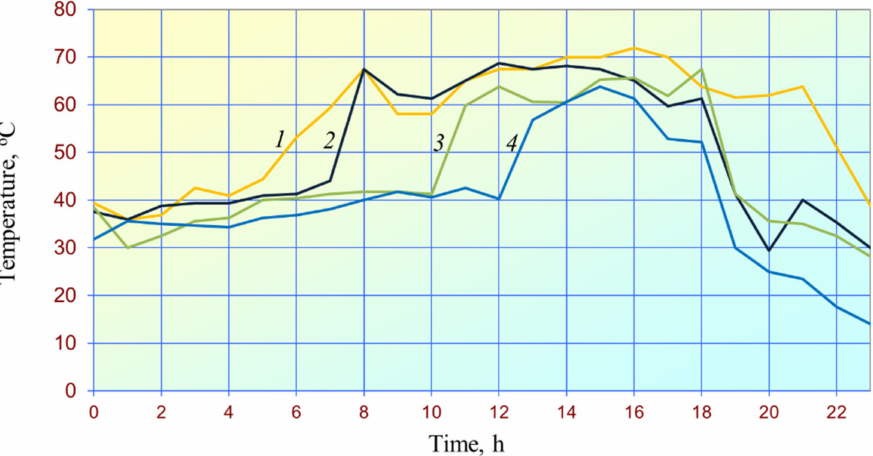
Figure 6. Variation in the average temperature of the heating agent in collector group 1 during the day in sunny weather at different outdoor temperatures: 1–27 June 2017 (+30 ◦ C); 2–8 April 2018 (+3 ◦ C); 3–11 March 2018 ( − 16 ◦ C); 4–25 February 2018 ( − 24 ◦ C).